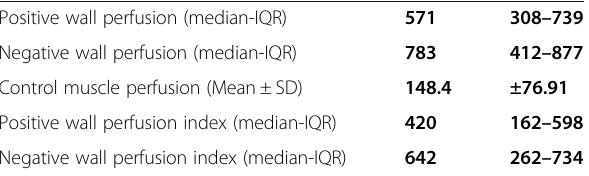
Table 1 Range of perfusion values and perfusion indices of the positive wall, negative wall, and control muscle perfusion in